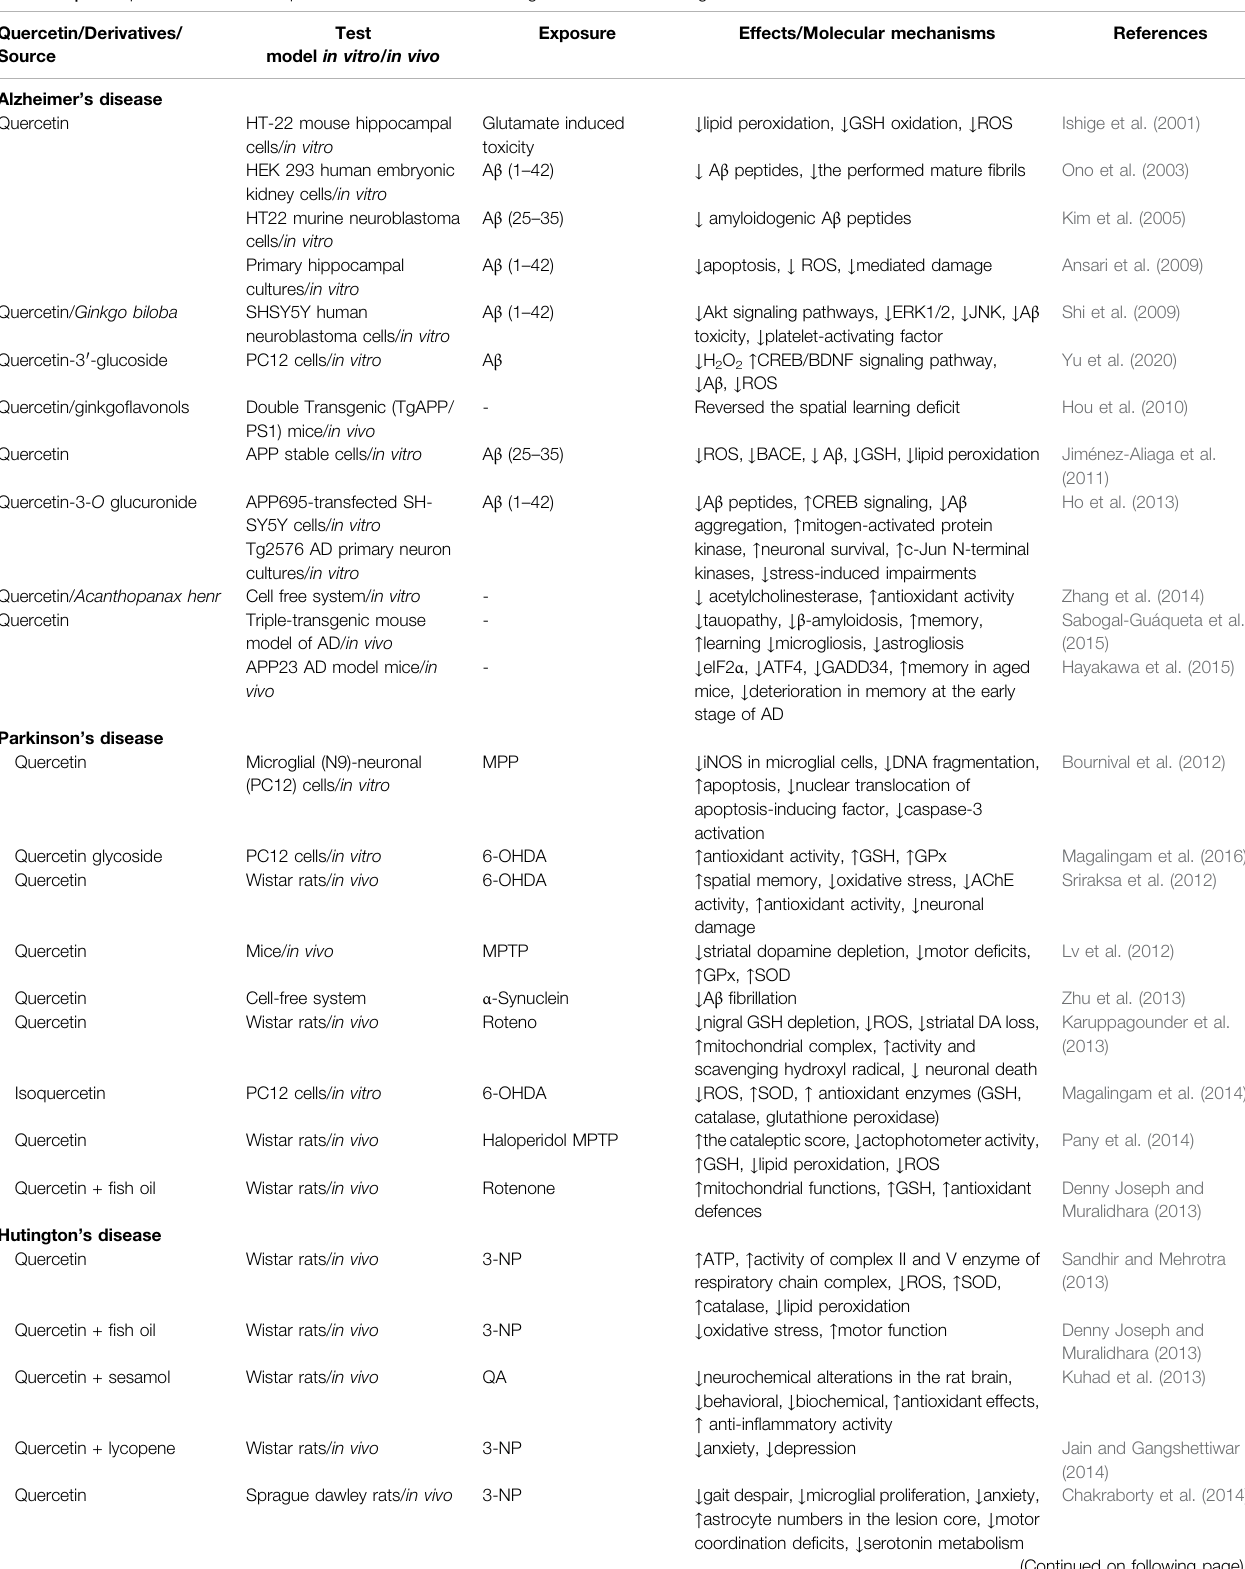
TABLE 1 | Neuroprotective effects of quercetin and/or its derivatives against various neurodegenerative diseases and other brain